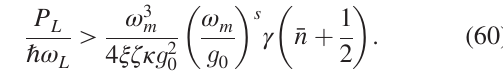
E ¼ . The blue and red m